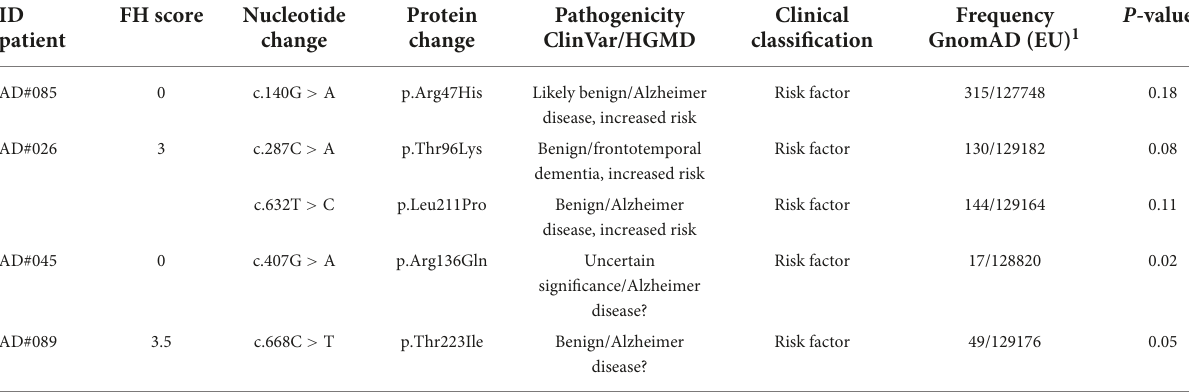
TABLE 3 Rare variants in AD-risk gene TREM2 identified in this